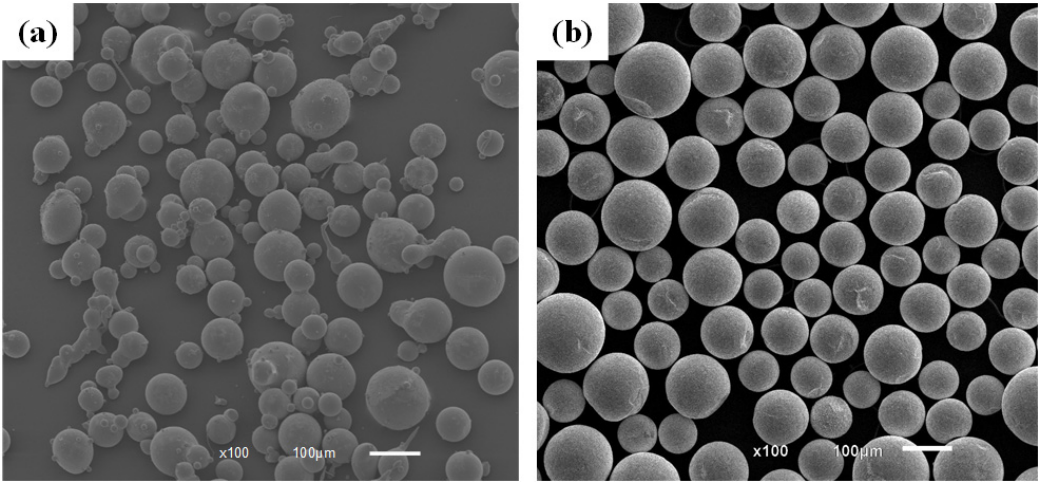
Table 2. Chemical compositions of the Ni60A substrate (wt%).